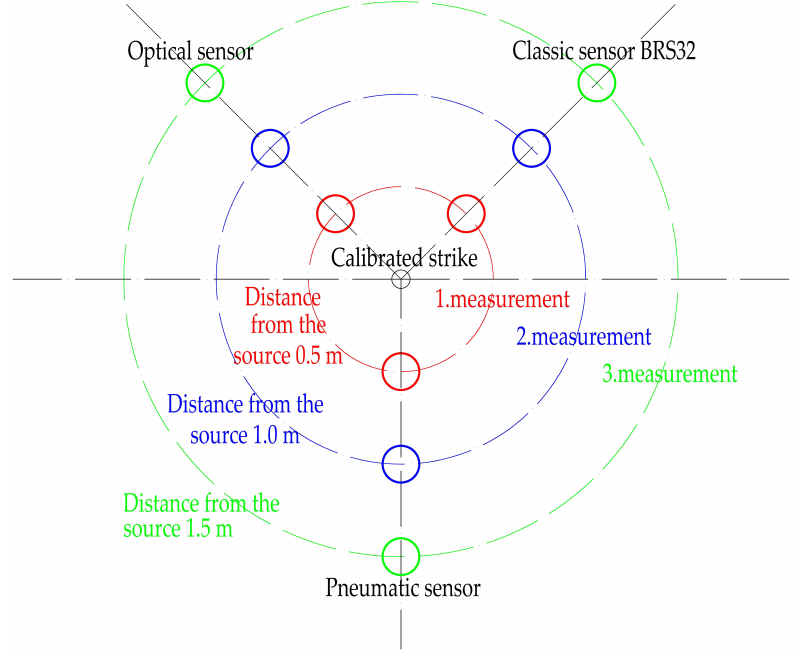
Figure 7. Diagram of the entire comparative